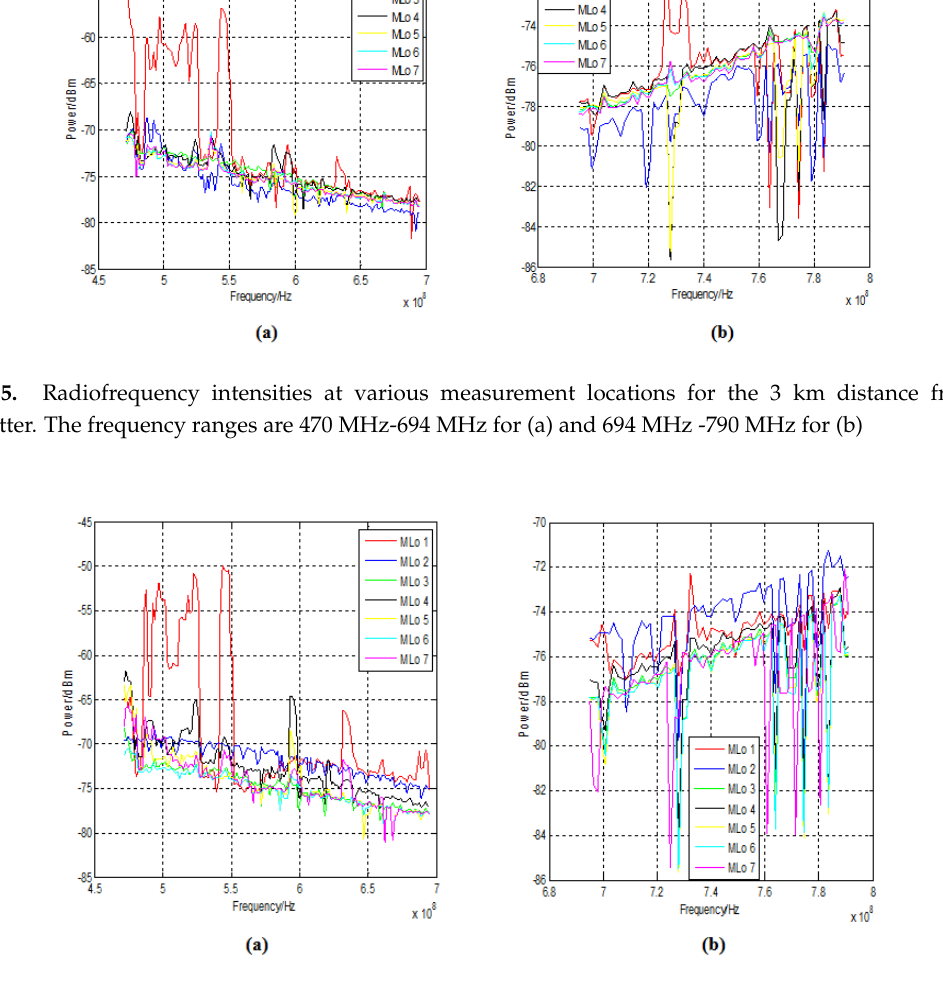
Figure 6. Radiofrequency intensities at various measurement locations for the 5 km distance from the transmitter. The frequency ranges are 470 MHz-694 MHz for (a) and 694 MHz -790 MHz for (b)